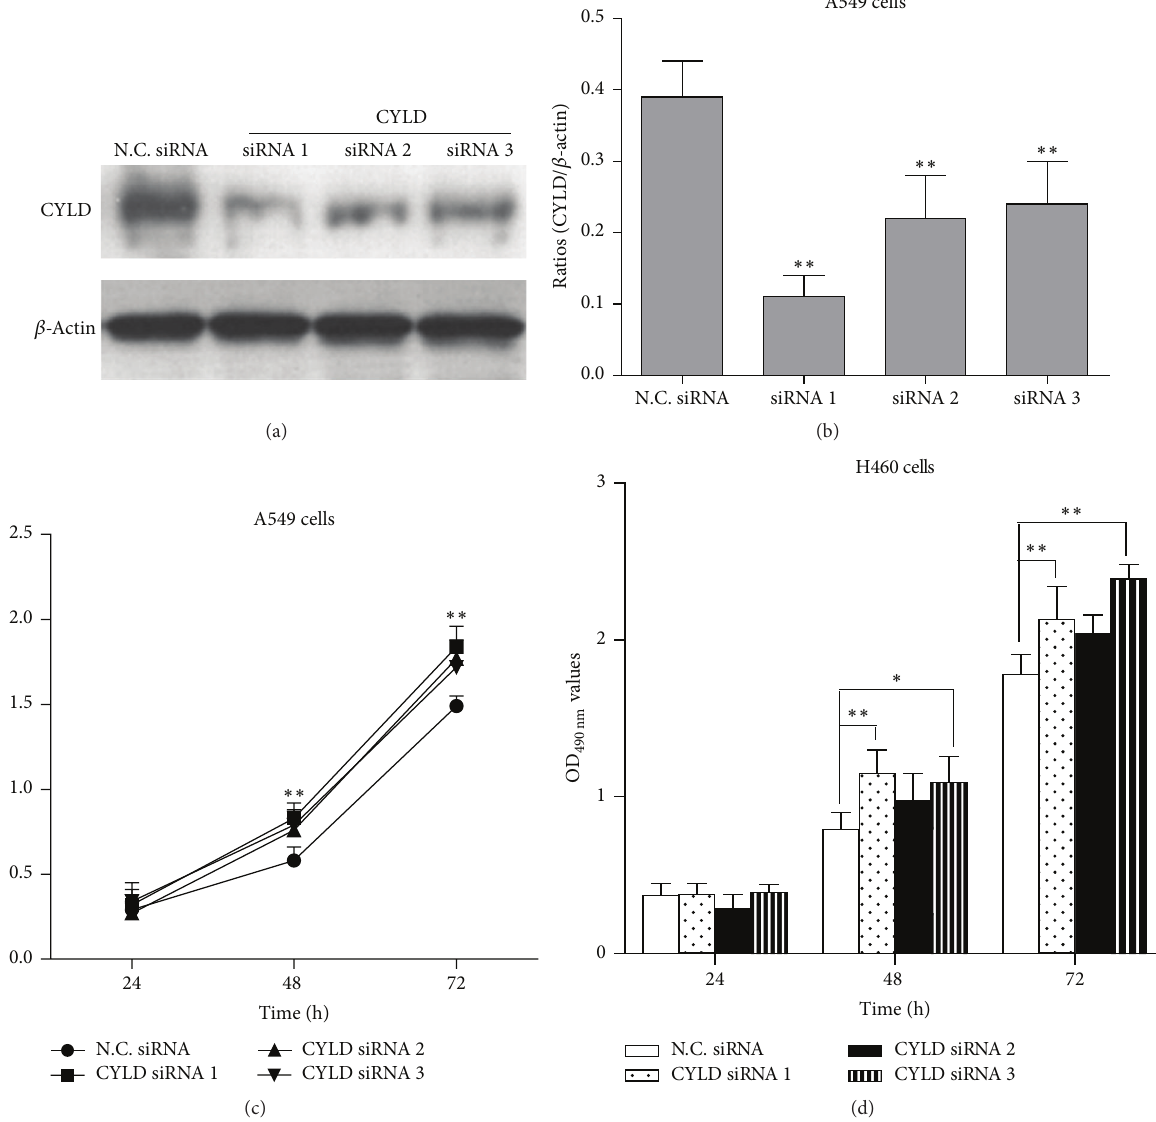
Figure2:KnockdownofCYLDbysiRNApromotesthegrowthofA549andH460cells.(a)TheA549cellswereplatedinto24-wellplate.Eight hours later, three pairs of CYLD-siRNA were transfected into A549 cells. The transfected cells were cultured for 48 hours; the expression of CYLDwasdetectedbywesternblottinganalysis.(b) 𝛽 -ActinwasusedasaninternalreferenceandN.C.siRNAwasusedasthenegativecontrol. The expression level of CYLD was normalized to the expression of 𝛽 -actin. ∗∗ 𝑝 < 0.01 , compared with the N.C. siRNA transfected group. (c) Cell viability was determined by MTT assay. The transfected A549 cells were cultured for 24 hours, 48 hours, and 72 hours, respectively, and the OD 490 nm values were detected by MTT assay. ∗∗ 𝑝 < 0.01 , compared with N.C. siRNA group. (d) H460 cells were transfected with three pairs of siRNA specific to CYLD and cultured for 24 h, 48 h, and 72 h, respectively. The cell viability was determined by MTT assay. ∗ 𝑝 < 0.05 , ∗∗ 𝑝 < 0.01 , compared with N.C. siRNA group.